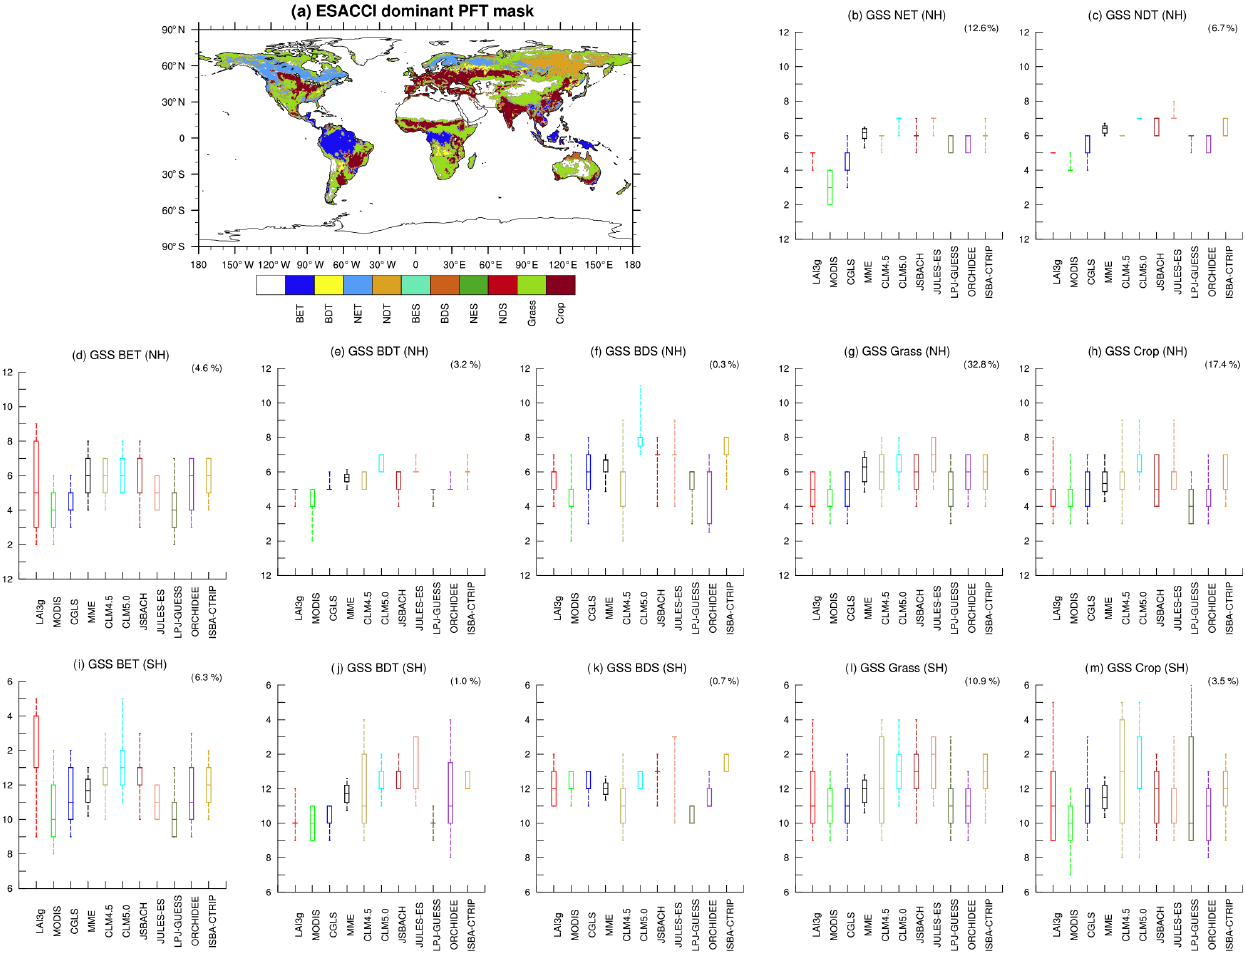
Figure 7. (a) Global distribution of the main land cover types for the 2000–2011 period based on ESA CCI data (Li et al., 2018). Comparison in the growing season start (GSS) timings between satellite products (LAI3g, red; MODIS, green; CGLS, blue) and land surface models (LSMs: MME, black; CLM4.5, dust; CLM5.0, cyan; JSBACH, dark red; JULES, pink; LPJ-GUESS, dark green; ORCHIDEE, purple; ISBA-CTRIP, dark yellow) in (b) needle-leaf evergreen tree (NET) in the Northern Hemisphere (NH); (c) needle-leaf deciduous tree (NDT) in the NH; broadleaf evergreen tree (BET) in the (d) NH and (i) SH; broadleaf deciduous tree (BDT) in the (e) NH and (j) SH; broadleaf deciduous shrub (BDS) in the (f) NH and (k) SH; grass-covered areas (Grass) in the (g) NH and (l) SH; and crop-covered areas (Crop) in the (h) NH and SH (m) . Note that no area is dominated by broadleaf evergreen shrub (BES), needle-leaf evergreen shrub (NES), or needle-leaf deciduous shrub (NDS) biome. The boxplots represent the median, 25/75th percentile, and 10/90th percentile of the distribution of grid points belonging to each biome illustrated in panel (a) . Each panel shows in parentheses the percentage of global vegetated area covered by each biome. Note that the y axis is different in the NH and SH panels, but in both cases the summer season is central along the